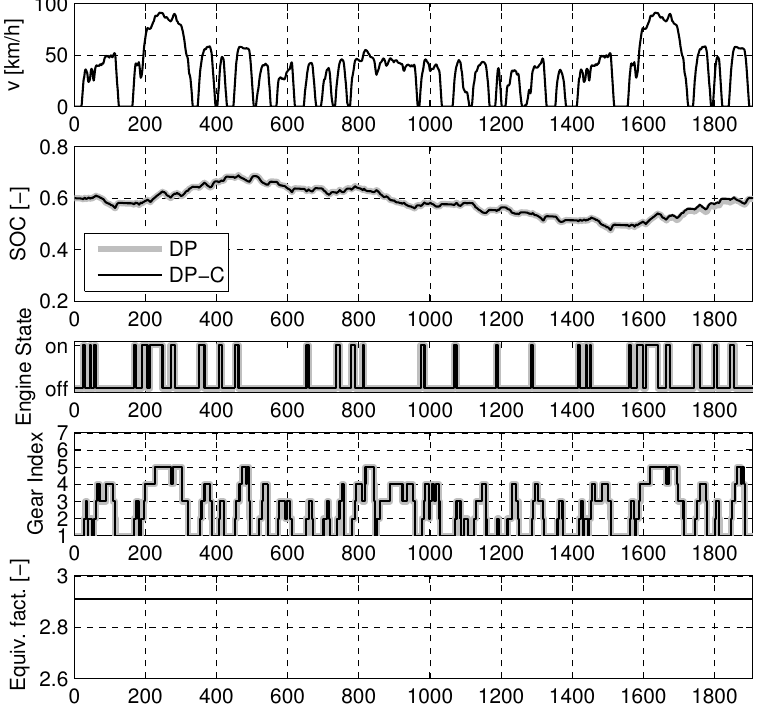
Figure 8. Comparison of the results obtained with DP and the DP-C algorithm on the Federal Test Procedure (FTP) driving